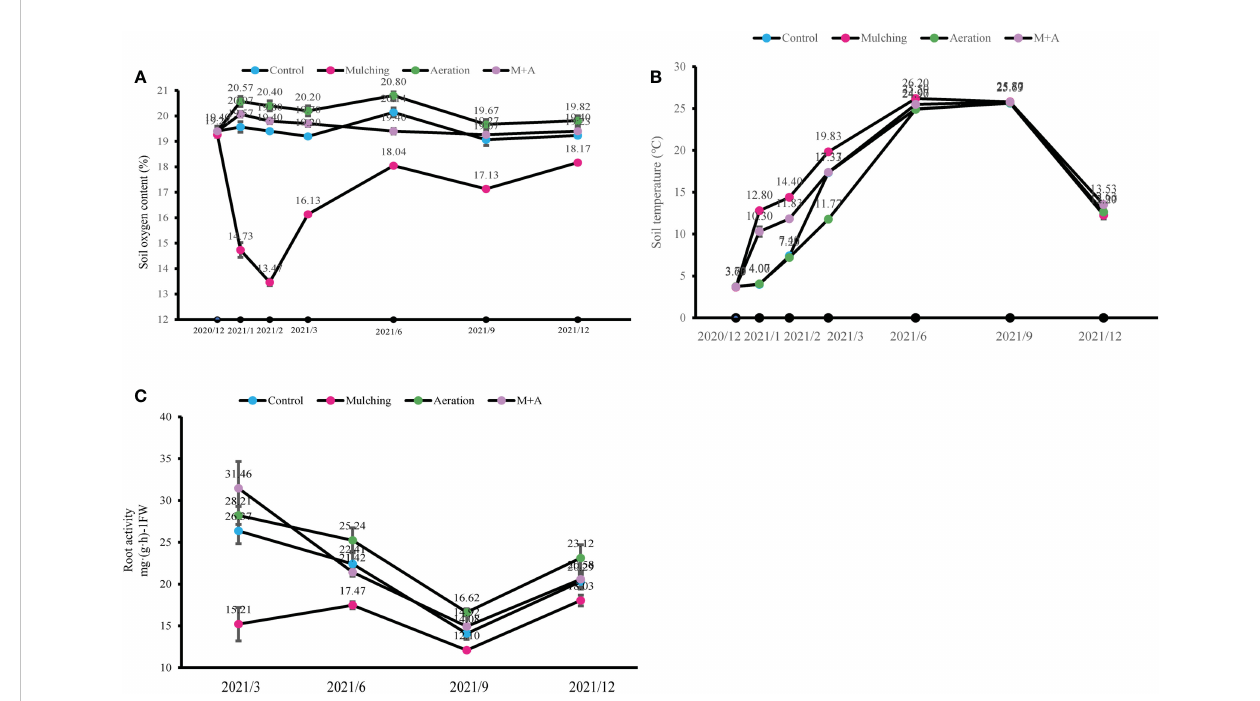
FIGURE 2 Effects of aeration on soil oxygen content (A) , temperature (B) and root respiratory activity (C) in the bamboo forest under mulching conditions (Control, Mulching, Aeration, M + A). The vertical bars ± re fl ect the standard deviation of the mean. Different letters in the same period represent different signi fi cance ( p<